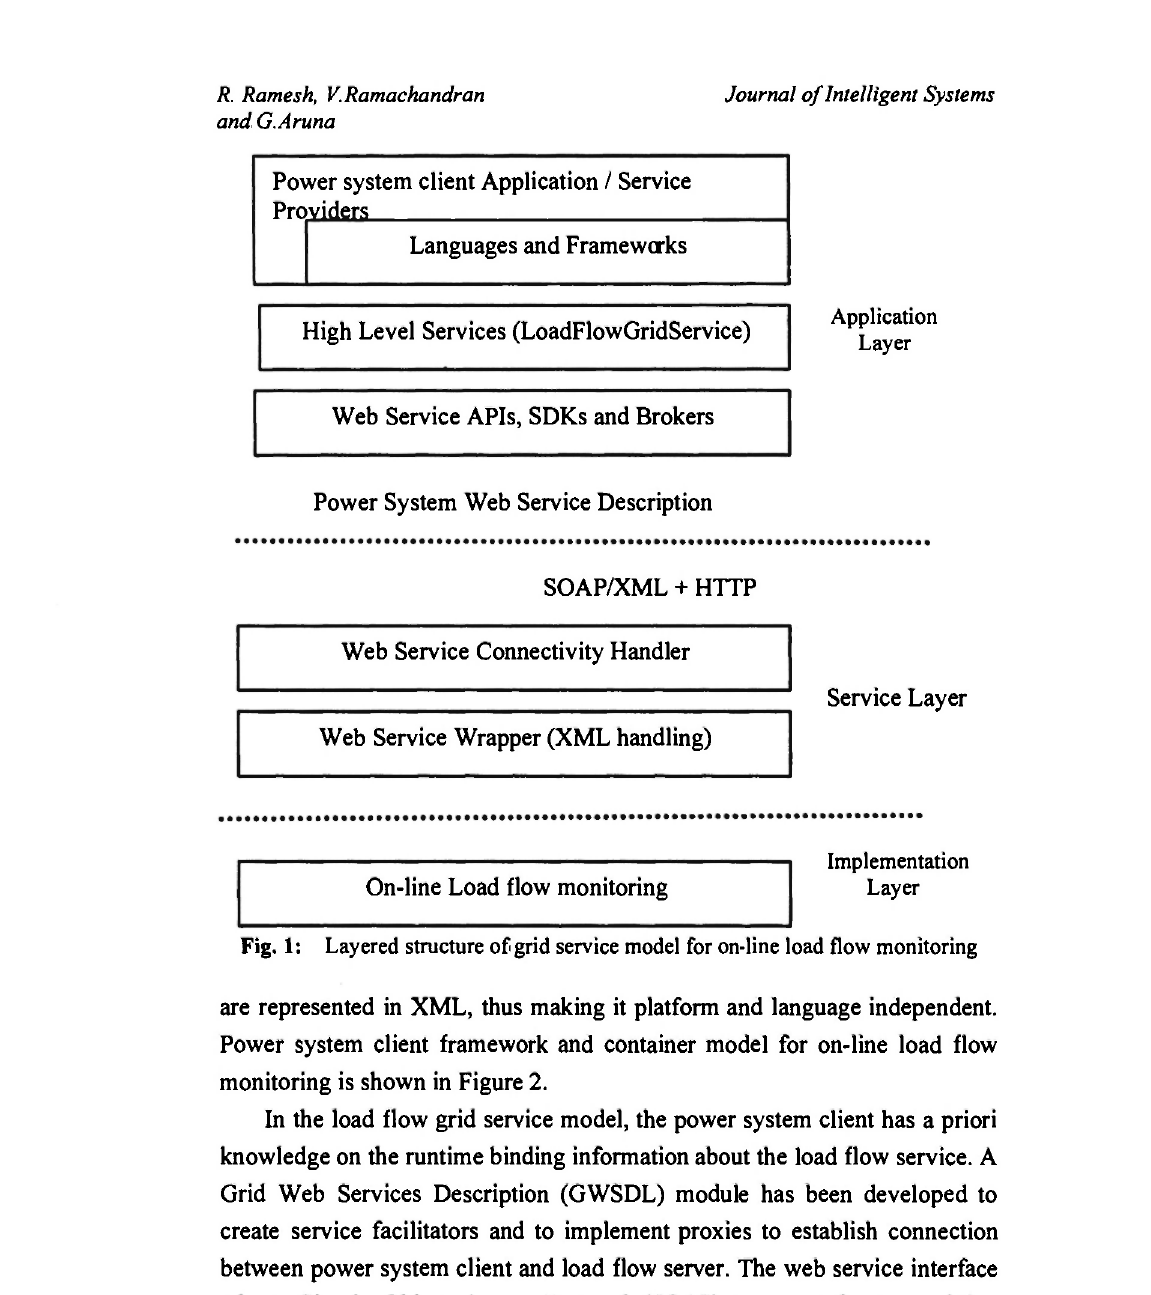
Fig. 1: Layered structure of grid service model for on-line load flow monitoring are represented in XML, thus making it platform and language independent. Power system client framework and container model for on-line load flow monitoring is shown in Figure